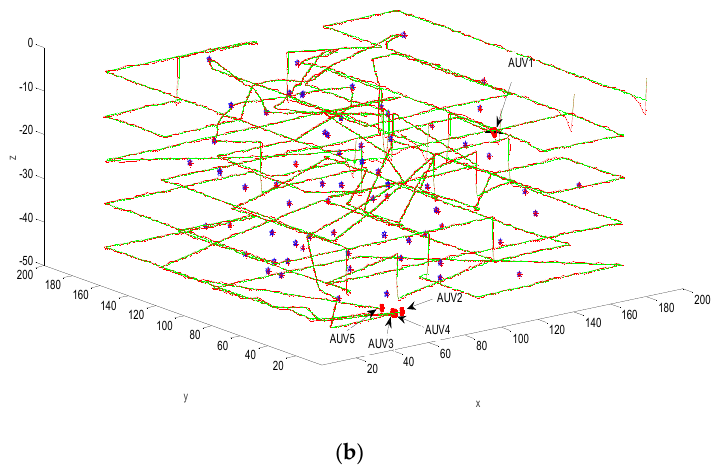
Figure 8. Search process when one AUV breaks down. ( a ) One AUV breaks down; ( b ) The AUV’s last search results.